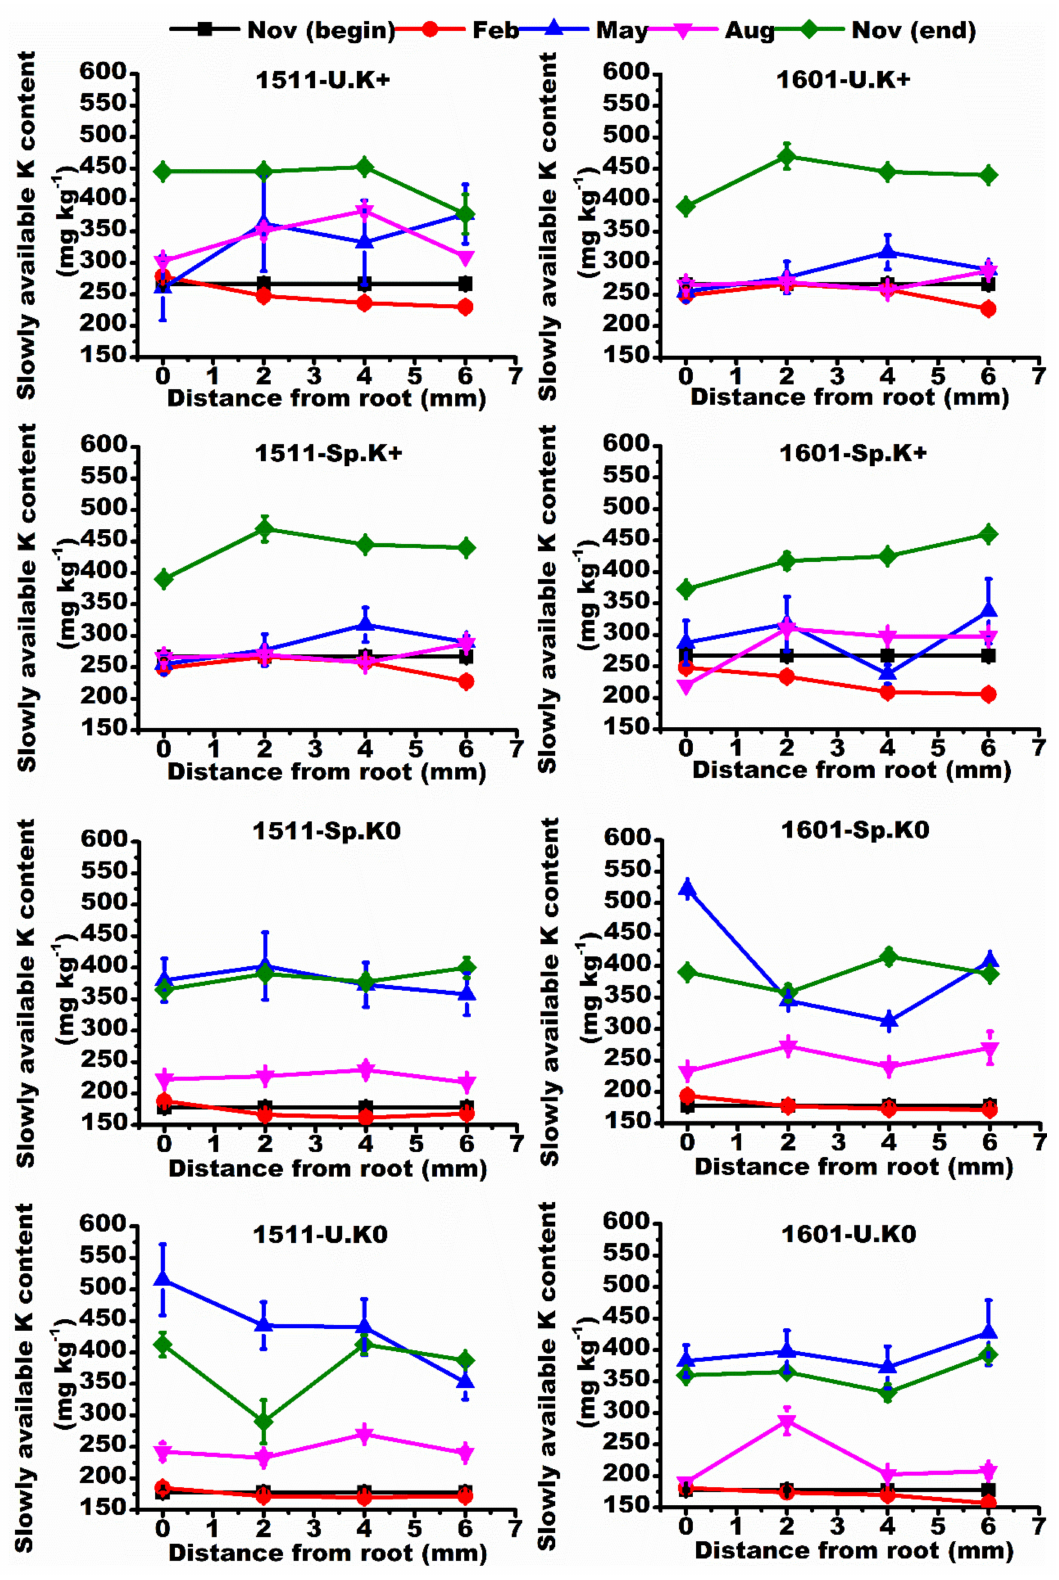
Figure 3. Spatiotemporal variations of slowly available K contents in soils. Different colored lines represent the spatial distribution of soil slowly available K in different months. Data are means ± SE ( n =